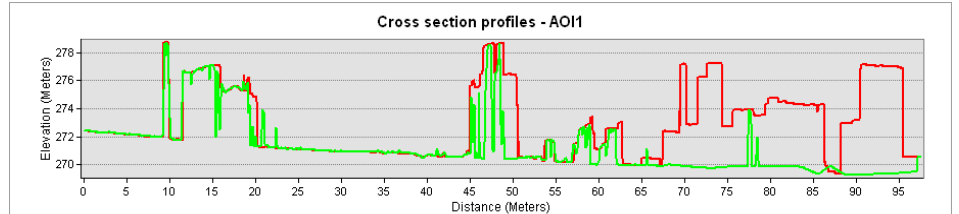
Figure 8. Vertical cross section of DSM obtained from photogrammetric software shown in Red and from Enhanced DSM obtained from research methodology shown in Green for the AOI1 region.